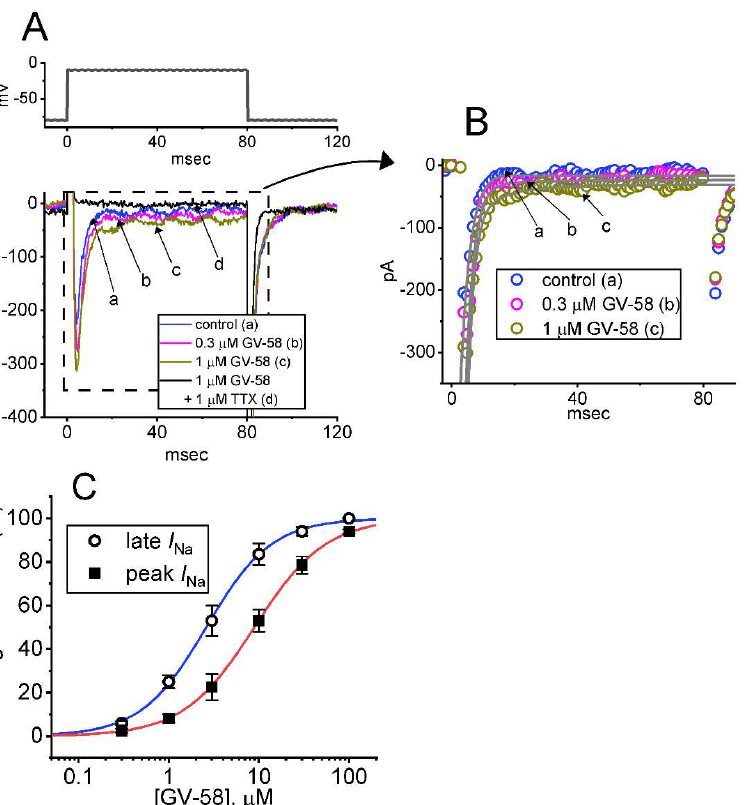
Figure 1. Stimulatory effect of GV − 58 on voltage-gated Na + current ( I Na ) in pituitary GH 3 cells. This stage of experiments was conducted in cells which were bathed in Ca 2+ − free Tyrode’s solution, and the solution contained 10 mM tetraethylammonium chloride (TEA) and 0.5 mM CdCl 2 . The recording electrodes that we used were filled up with a Cs + − enriched solution. ( A ) Representative current traces activated by short depolarizing pulse (indicated in the upper part). Current trace labeled “a” was obtained during control (i.e., absence of GV-58), those labeled “b” or “c” were recorded during the exposure to 0.3 or 1 μM GV − 58, and that labeled “d” was obtained in the presence of 1 μM GV-58 plus 1 μM tetrodotoxin (TTX). In ( B ), current traces (indicated in open circles) indicate an expanded record from dashed box of (A) for a higher time resolution. Of note, current trace labeled “d” was skipped. The gray lines overlaid on each trace indicate best fit to the data points with a two-exponential function. ( C ) Concentration − dependent response of GV − 58 − mediated stimulation of peak or late I Na residing in GH 3 cells (mean ± SEM; n = 8). The peak and late components of I Na activated in response to the depolarizing pulse from −80 to −10 mV were taken at the start and the end − pulse of the depolarizing command voltage with a duration of 80 ms. The continuous line (blue and red colors) indicates the best fit to a modified Hill equation, as revealed in Materials and Methods.